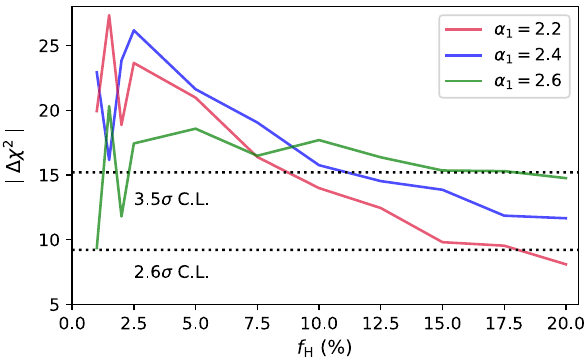
Fig. 6 | Δχ 2 | values between the one-population and two-population model for non-trivial redshift evolution and two d.o.f as a function of the pure-proton fraction f H . Three lines correspond to three values of proton injection